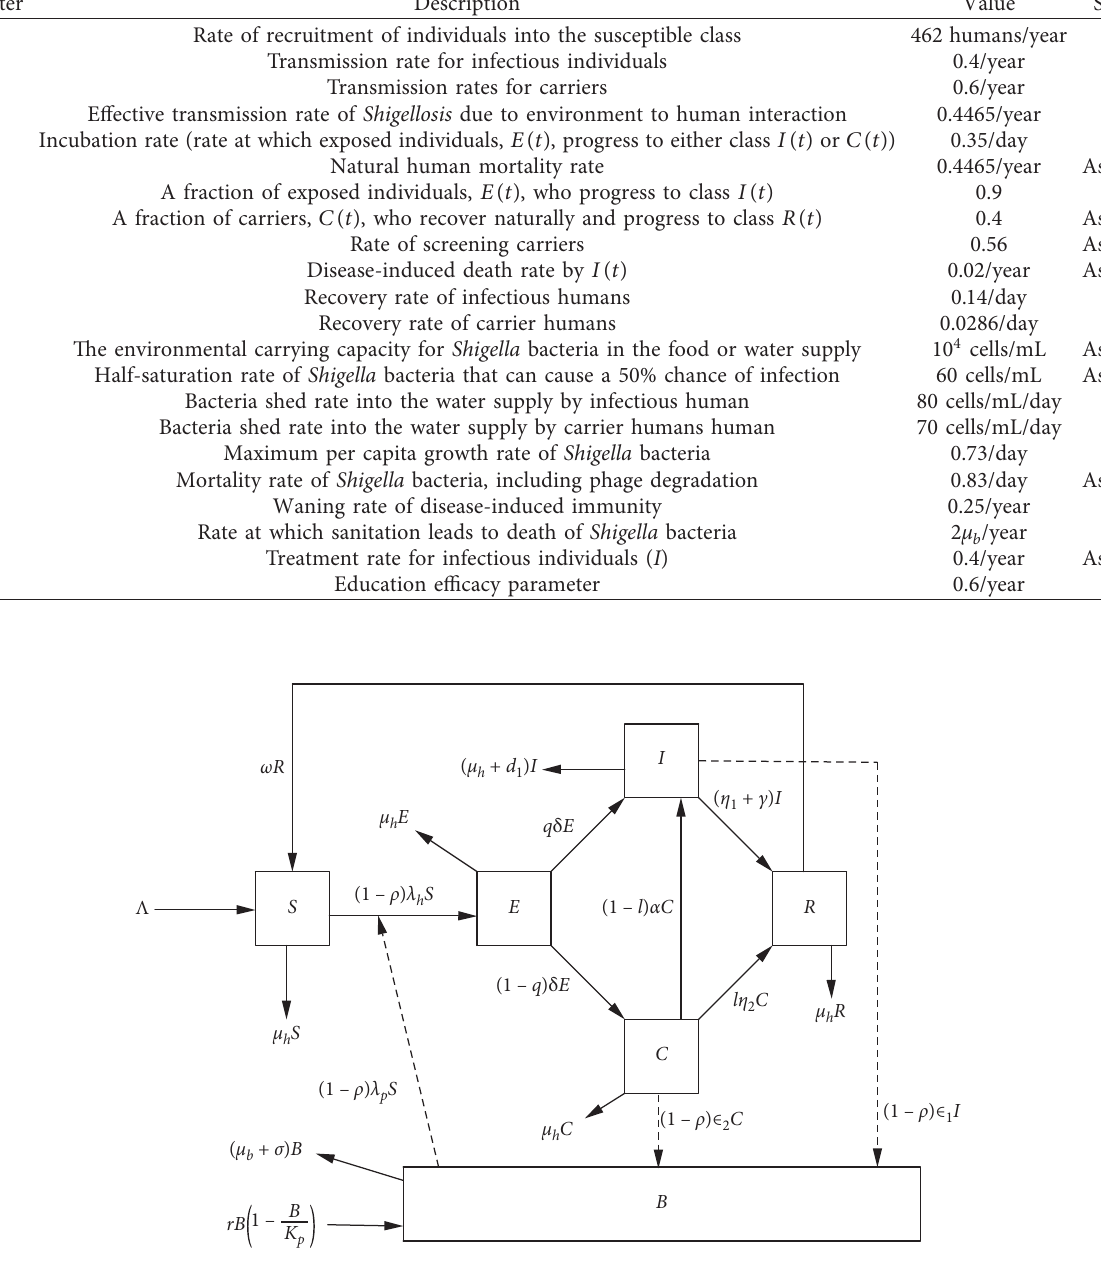
Figure 1: A flow diagram for Shigellosis transmission